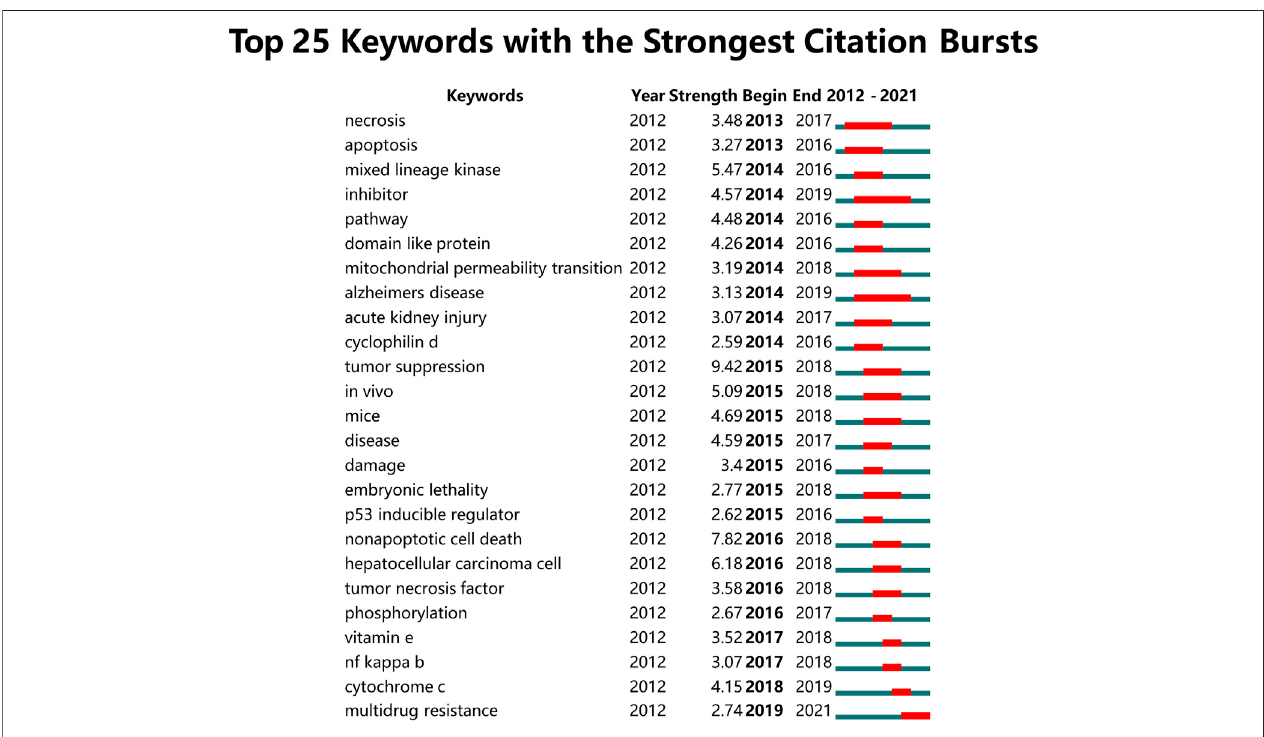
FIGURE 6 | Top 25 keywords with the strongest citation bursts involved in ferroptosis in cancer. (Sorted by the beginning year of burst.)